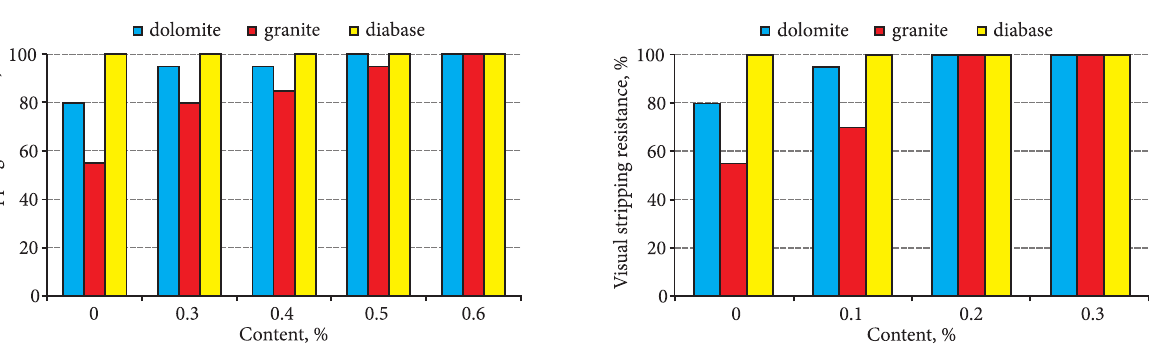
Fig. 2. Stripping resistance with bitumen B70/100 form Orlean Lithuania containing polyaminoamide based liquid